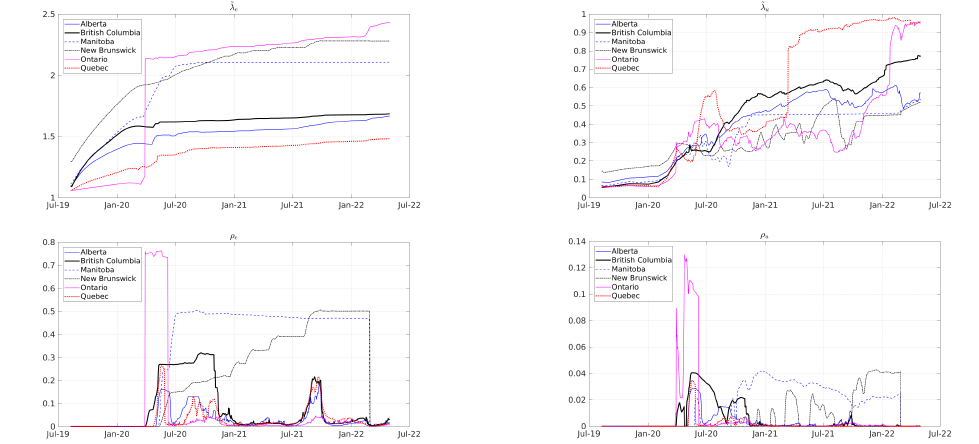
Figure 3. Seven-day moving average of the time series for the estimated values of the baseline transition rates into employment ˜ λ e ( t ) and unemployment ˜ λ u ( t ) , as well as the sensitivities ρ e ( t ) and ρ u ( t ) of transition rates with respect to new infections for Alberta, British Columbia, Manitoba, New Brunswick, Ontario, and Quebec.